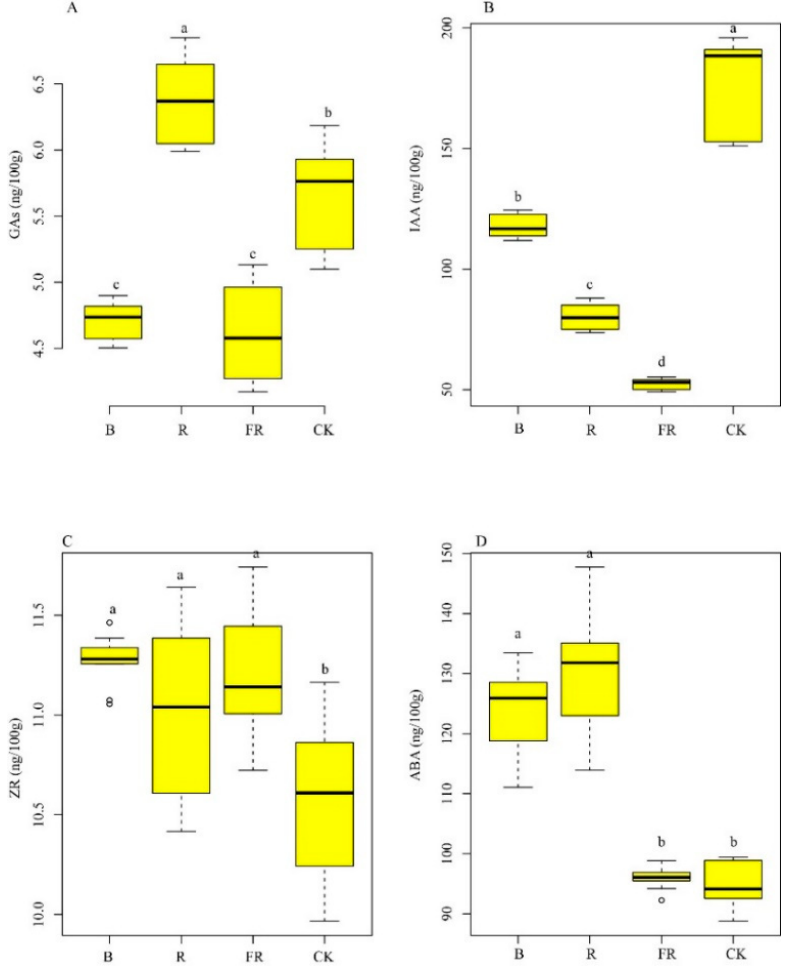
Figure 2. Multiple comparisons of GAs ( A ), IAA ( B ), ZR ( C ), and ABA ( D ) levels of seedlings treated with blue (B), red (R), far-red (FR) and a combination of B, R and FR lights (CK). Lowercase letters, a, b, represent Duncan group.